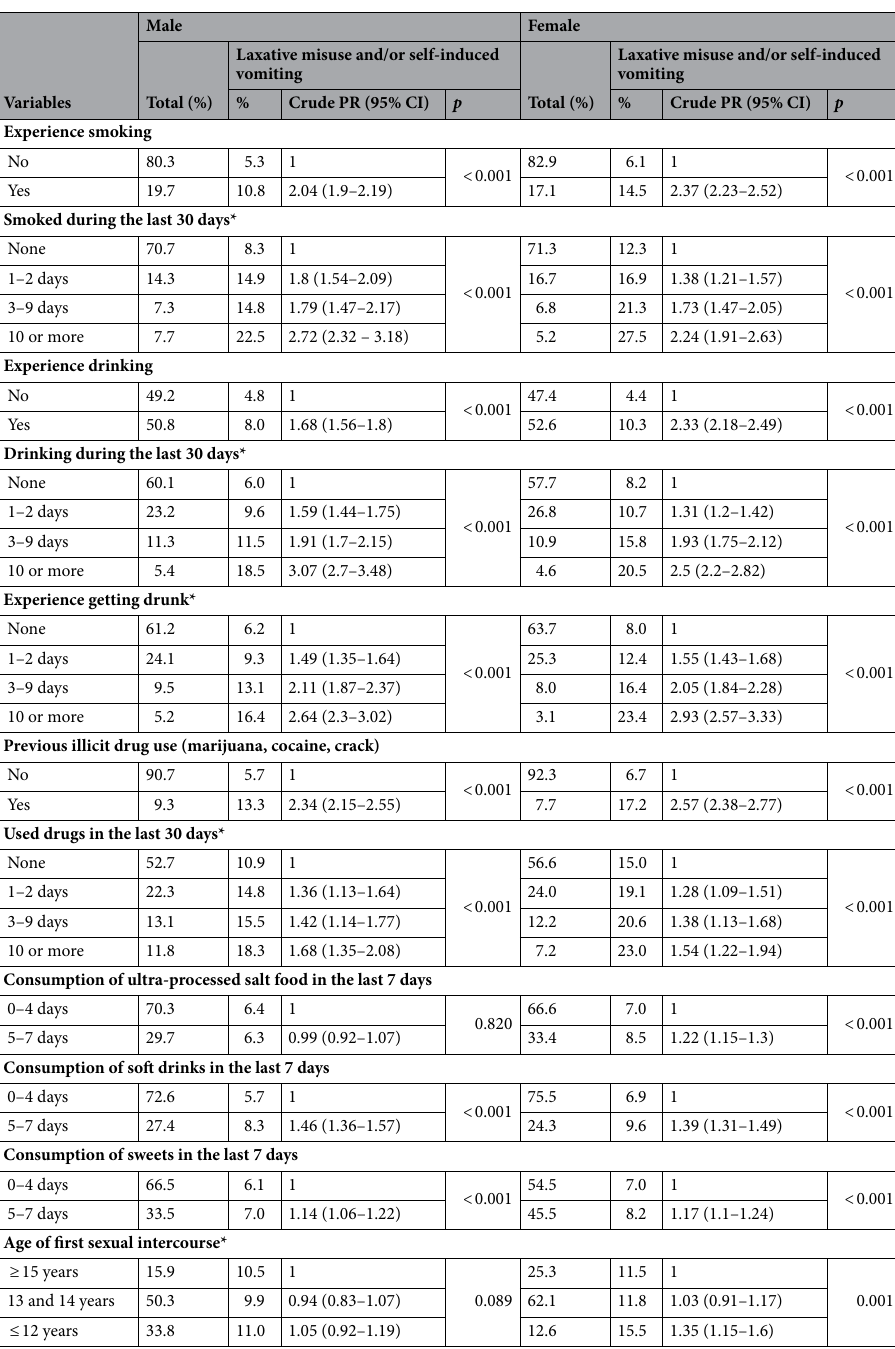
Table 2. Association between unhealthy life habits and laxative misuse and/or self-induced vomiting in Brazilian adolescent boys and girls (N = 102,072). The analysis was conducted using the Poisson regression model with robust variance. The effect measure is the PR with its respective 95% CI. Crude PR unadjusted prevalence ratio, 95% CI 95% confidence interval. * Only where